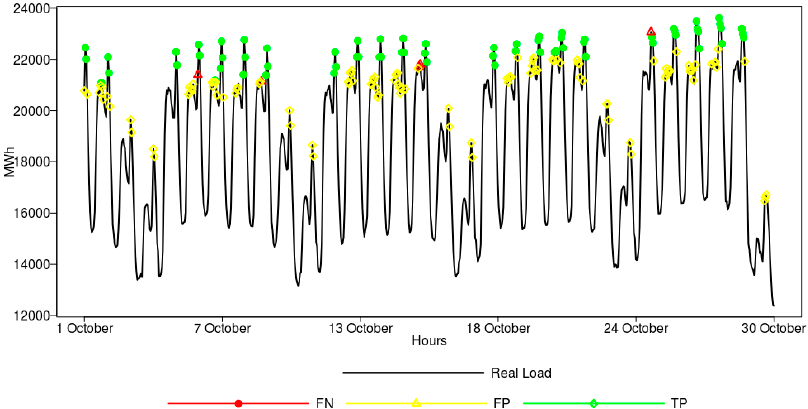
Figure 6. ANN peaks identification in the load data exceeding the 90th quantile of the distribution (October 2015 data).